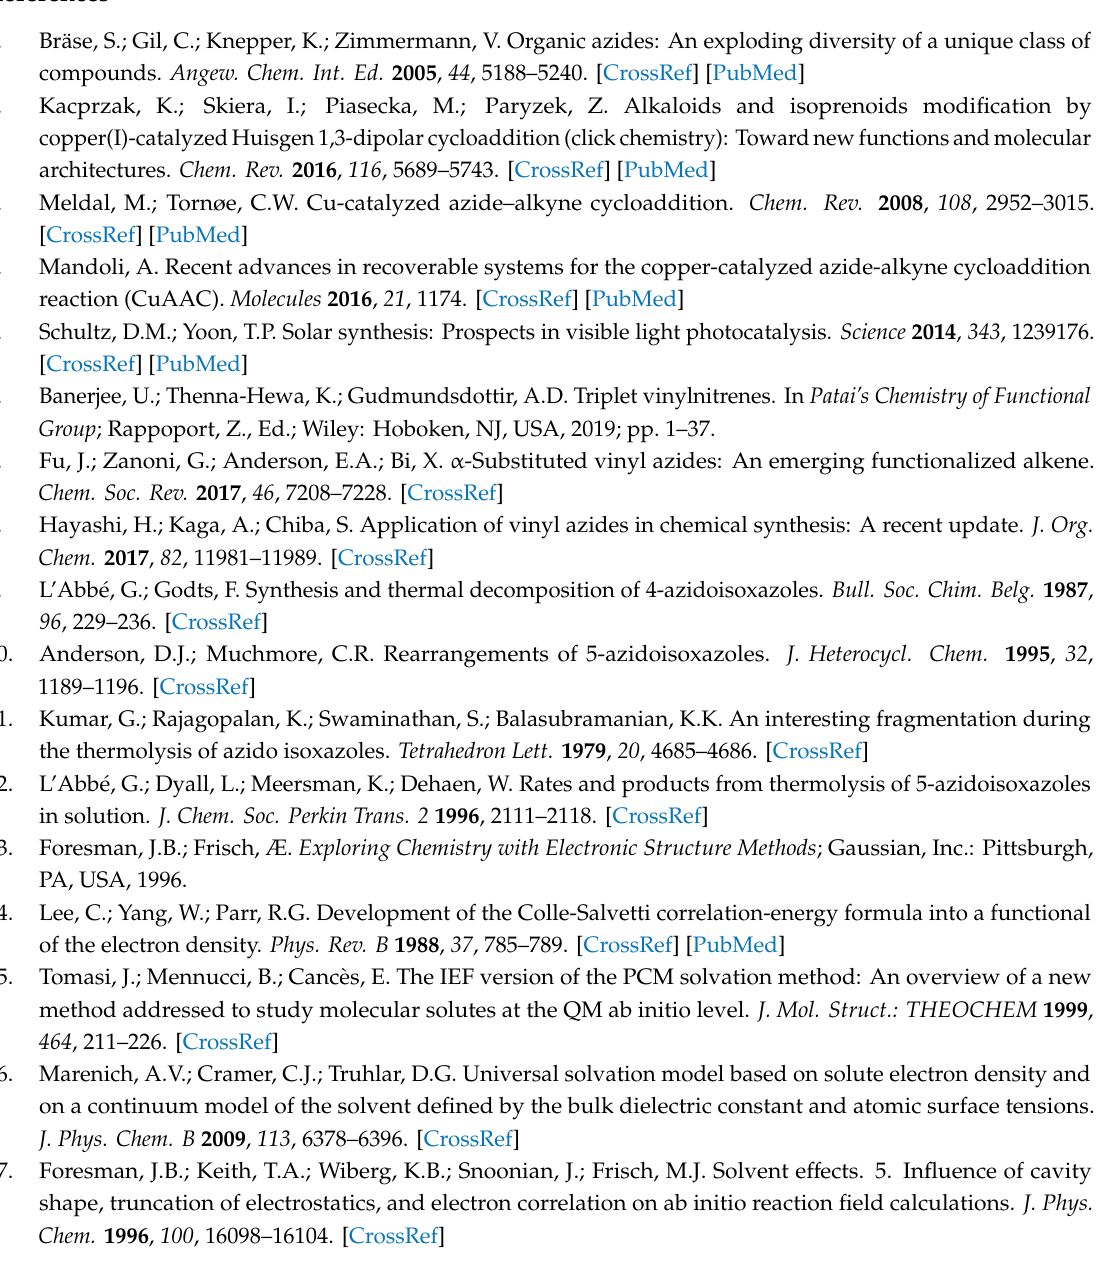
Figure S1: UV-Vis absorption spectra of azidoisoxazole 1 . Optimized structures of 1 – 3 ; CASSCF and CASPT2 absolute energies of nitrenes 1 2 and 3 2